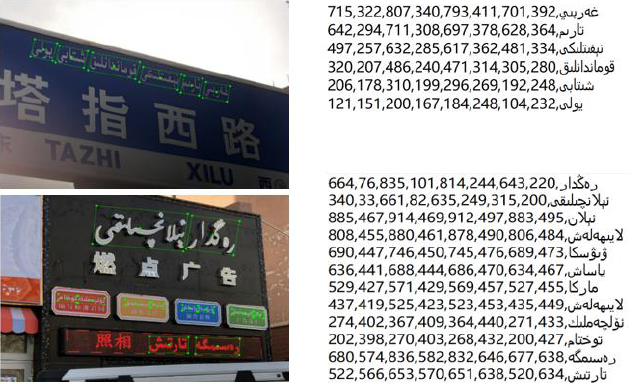
Figure 6. Annotation example of Uyghur dataset. The image on the left is the annotation box of visual Uyghur words, and the image on the right is the coordinates of the four vertices of the annotation text box and the corresponding text content. (Text description in the figure: Tazhi West Road and Burning advertisement.) According to the text area characteristics of the self-built scene Uyghur dataset, this paper makes quantitative statistics on the tilt angle of the multi-directional text box and the area of multi-scale text box, respectively. The statistical results are shown in Figures 7 and 8, respectively.